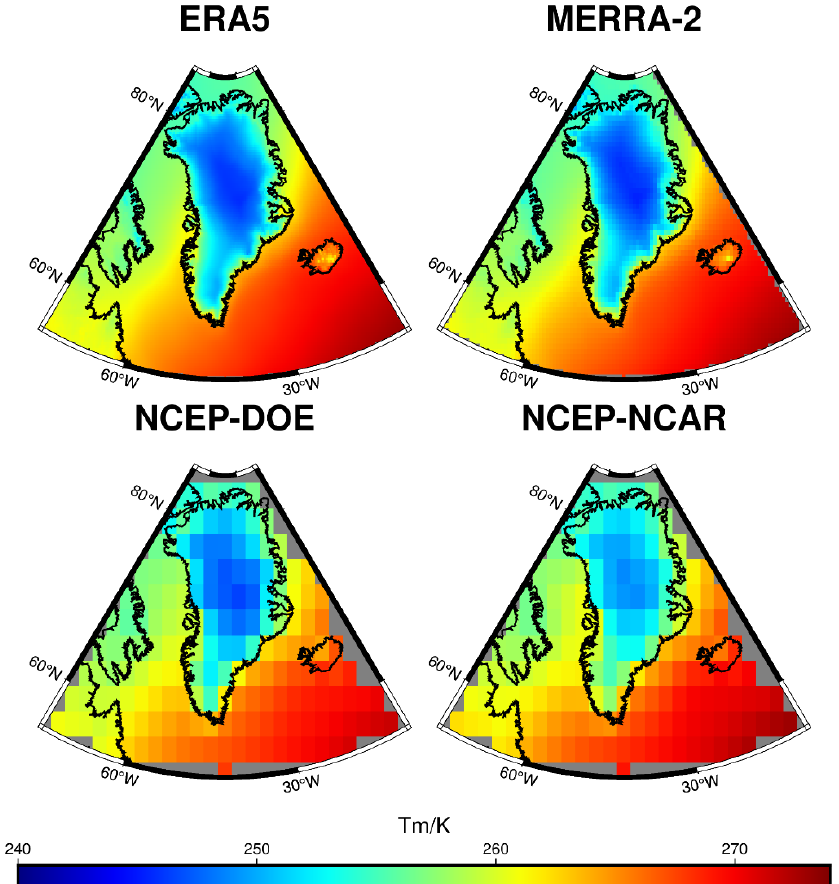
Figure 7. Mean T (cid:2923) computed from the four reanalysis data in Greenland from 2005 to 2019. Figure 7. Mean T m computed from the four reanalysis data in Greenland from 2005 to